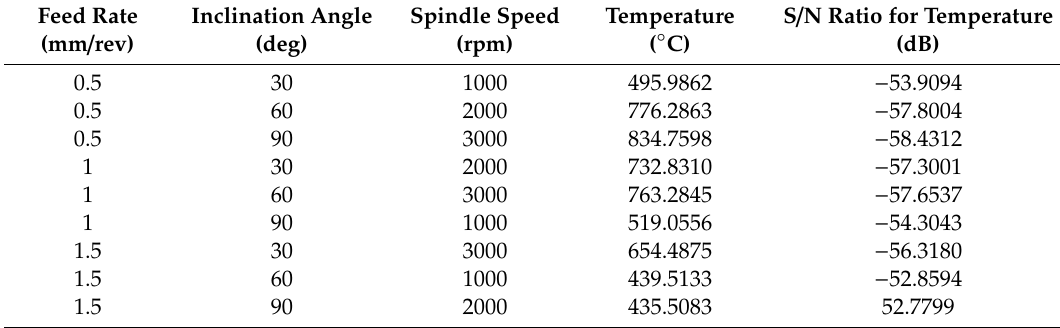
Table 11. The measured cutting temperature responses and the corresponding signal to noise ratios.